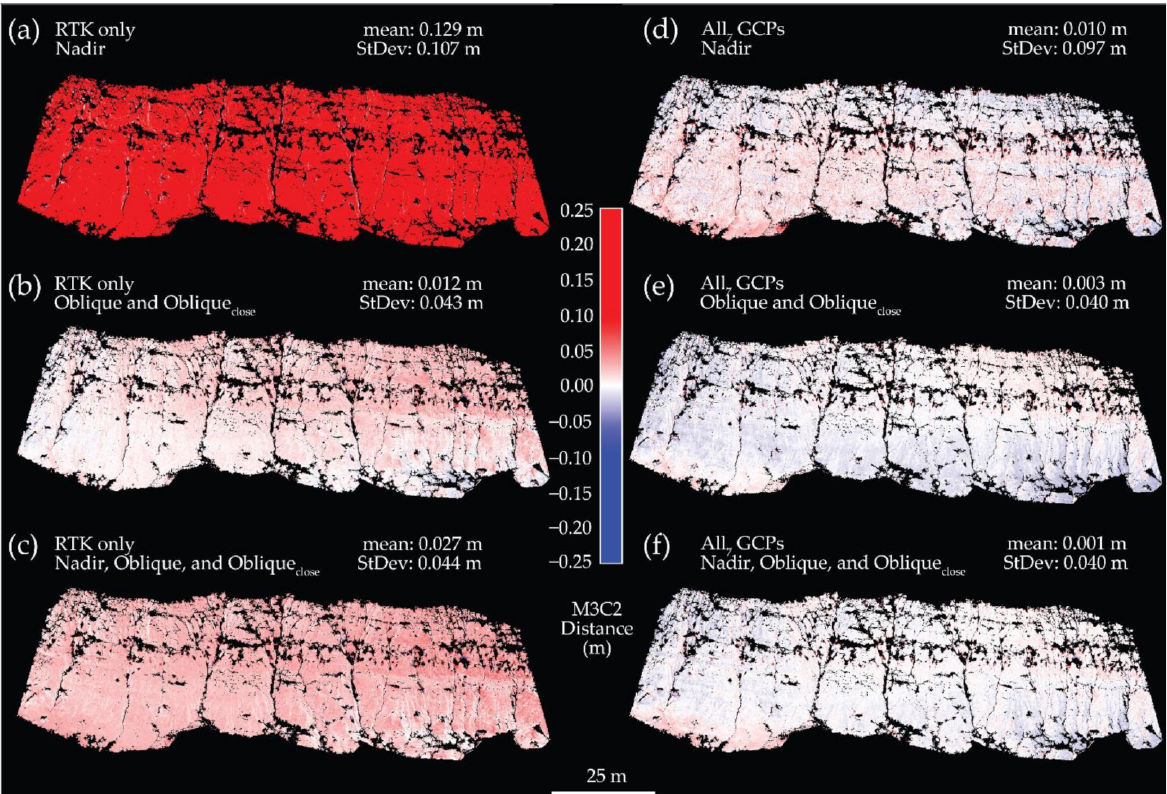
Figure 3. M3C2 differences for select RTK only scenarios ( a – c ) and All 7 GCP scenarios ( d – f ). Positive values (red) indicate UAV-SfM datasets below TLS reference surface, negative values (blue) indicate TLS reference surface below UAV-SfM. Note mean and standard deviation (StDev) results documented for each scenario.